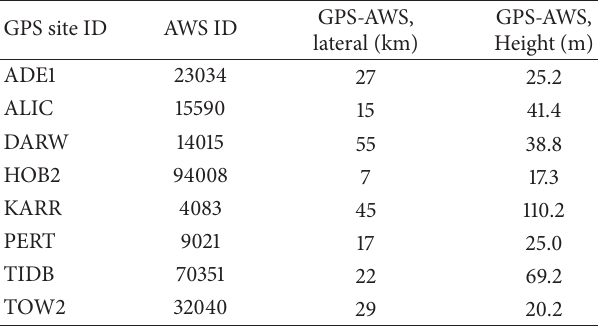
Table 3: Approximate lateral distances (km) and height differences (m) between the GPS and AWS